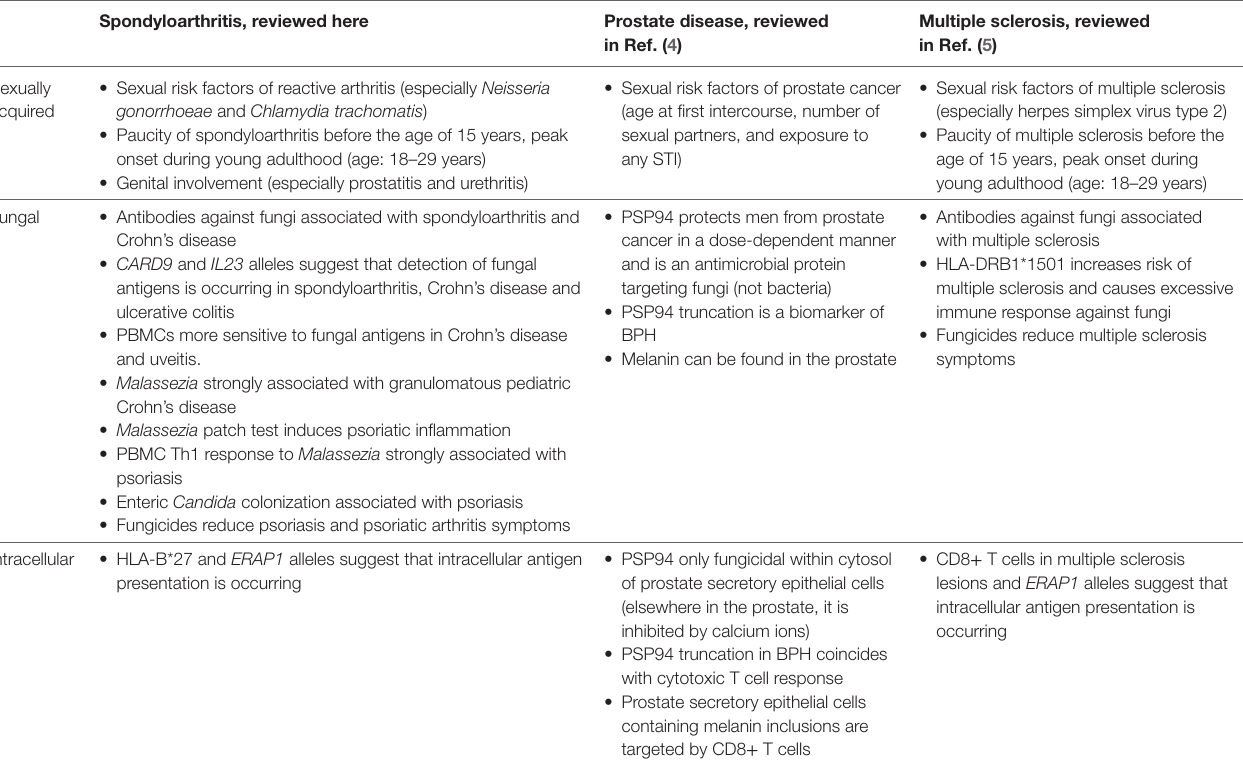
table 4 | Main observations supporting a common sexually acquired intracellular fungal infection in spondyloarthritis, prostate disease, and multiple sclerosis. spondyloarthritis, reviewed here prostate disease, reviewed